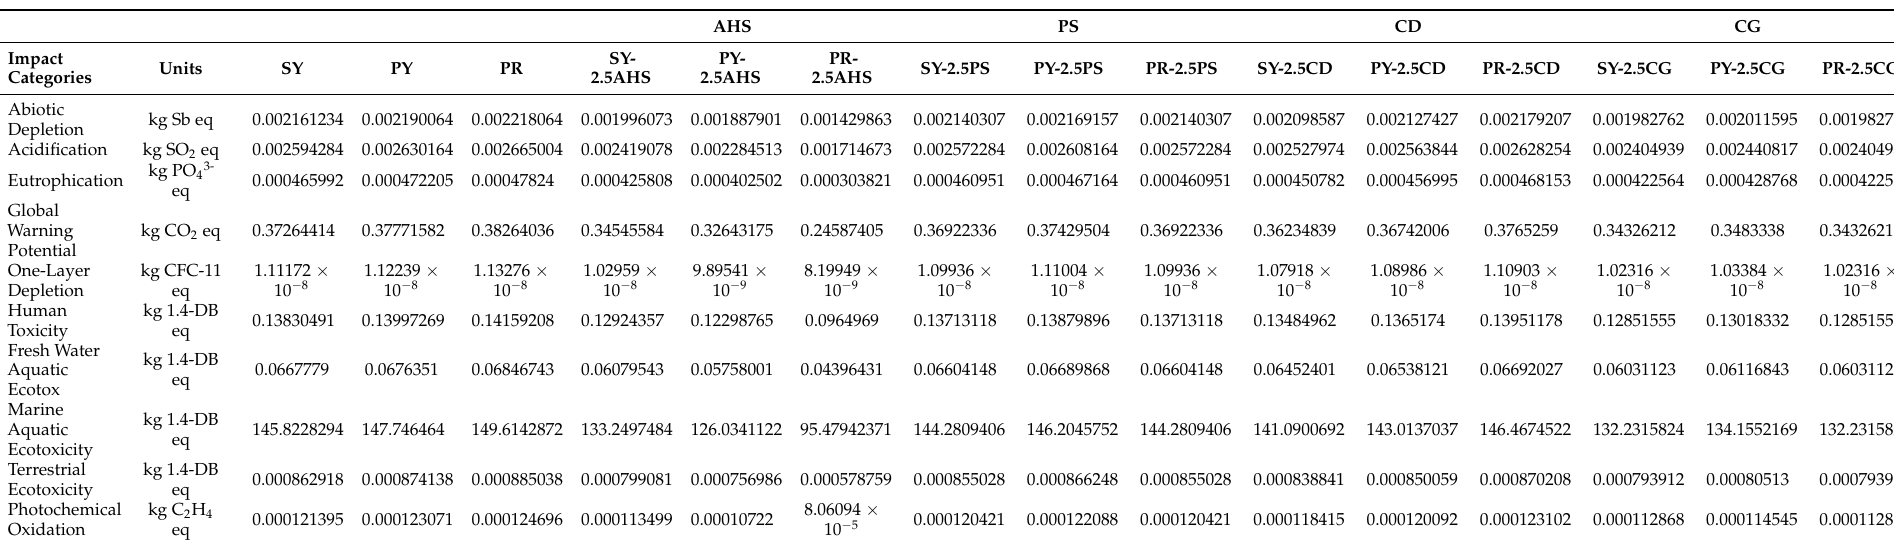
Table 4. Characterized impacts associated with 1 kg of lightweight aggregates incorporating 0 and 2.5 wt % of AHS, PS, CD and CG,